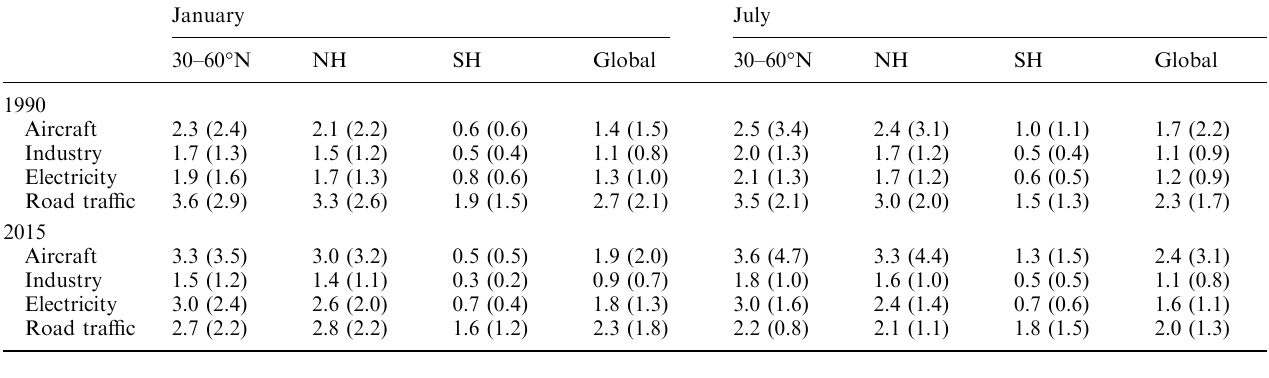
sources to the O burden (%) from the ground to 150 hPa and from 450 to 150 hPa (in x 3